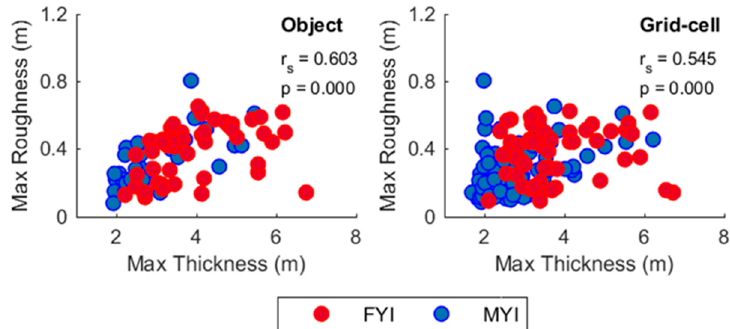
Figure 12. Scatter plots of maximum roughness as a function of maximum thickness at the medium scale using object ( left ) and 240 m grid-cell ( right ) aggregation approaches. Spearman correlation coefficients (r s ) and corresponding p -values are shown for pooled FYI and MYI data.